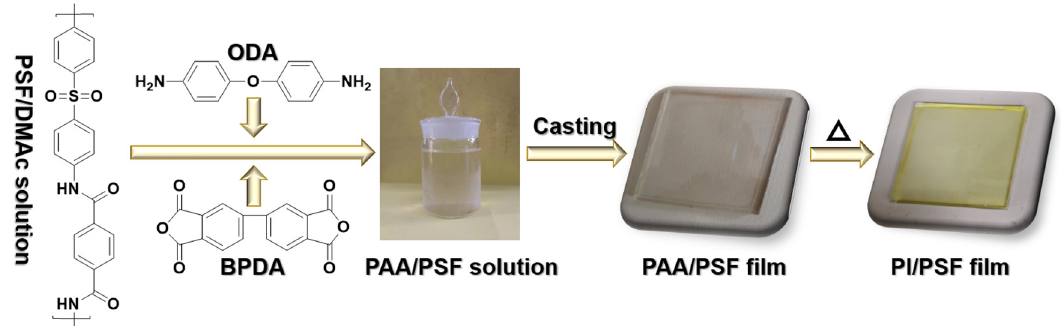
Figure 1: Schematic on the preparation of PI/PSF - X from PSF solutions, BPDA and ODA by in situ polymerization.